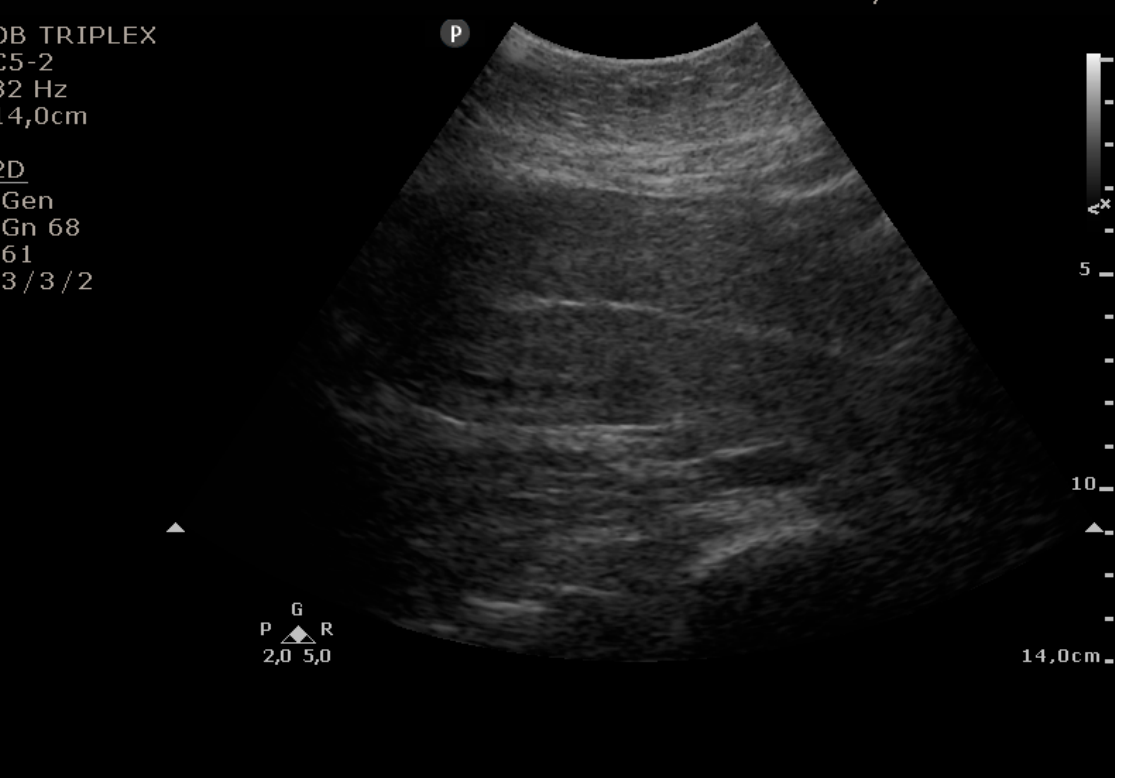
Figure 1. Grade 0: no blood or debris in the uterine cavity.